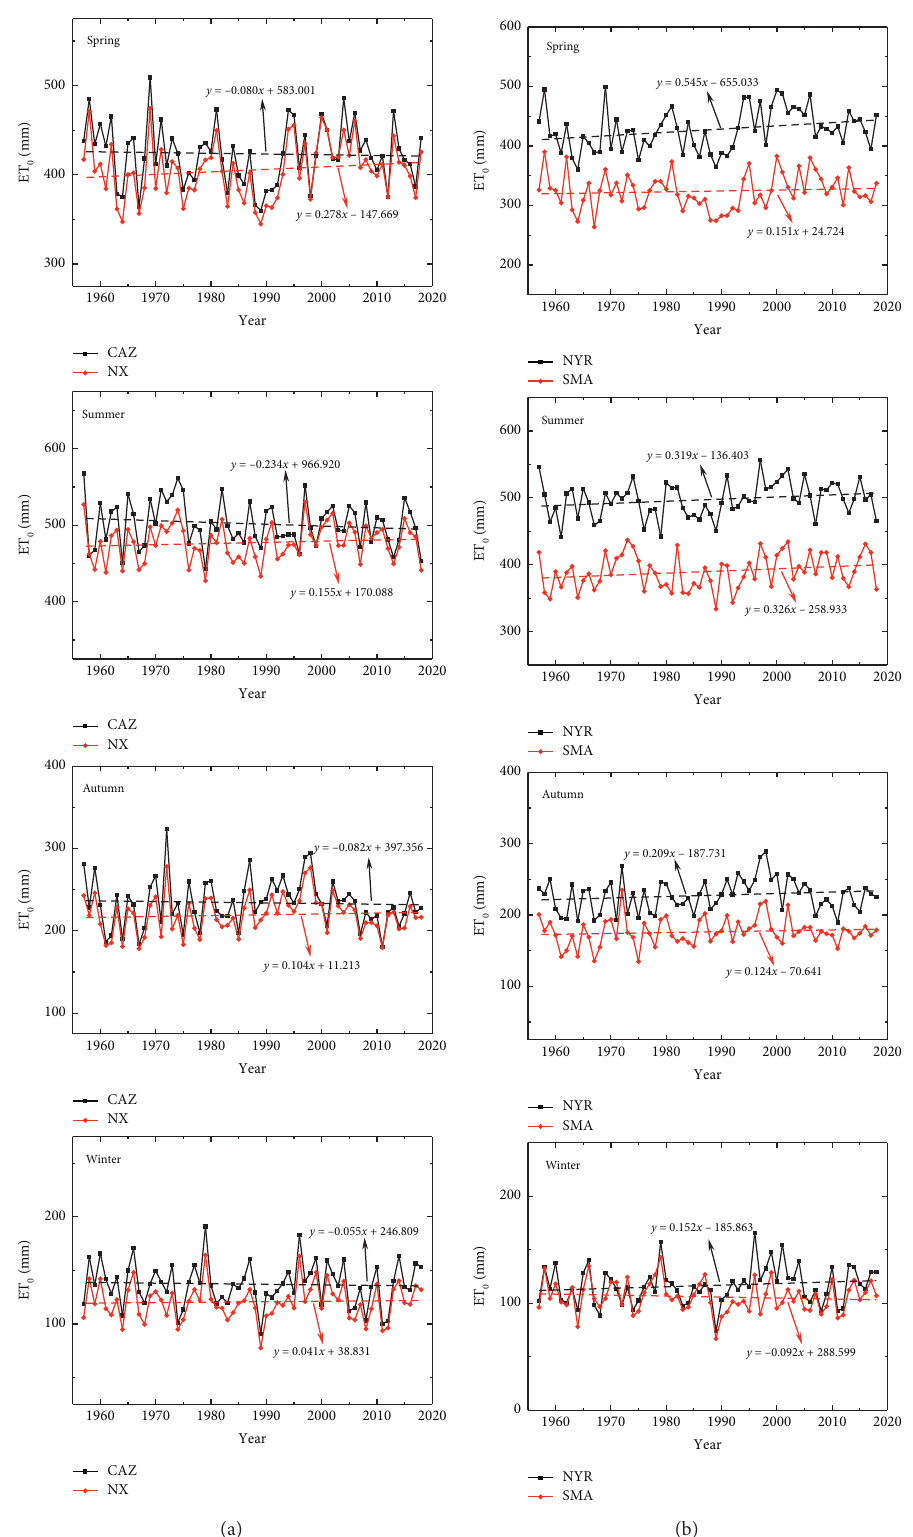
Figure 8: Temporal variations in seasonal ET 0 (spring, summer, autumn, and winter) from 1957 to 2018 over the NX, NYR, CAZ, and